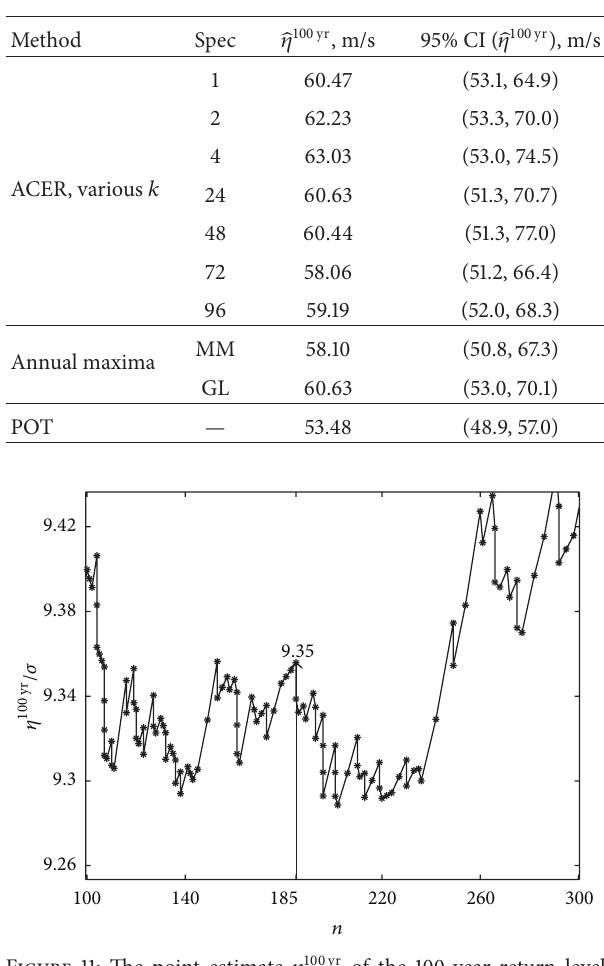
Figure 11: The point estimate 𝜂 100 yr of the 100-year return level based on 14 years hourly data as a function of the number 𝑛 of data points above threshold. 𝜎 = 5.72 m /